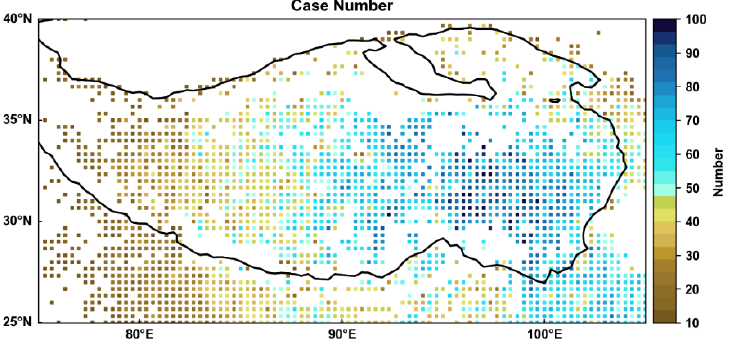
Figure 1. The schematic diagram of the studied region and the case numbers of the convective cloud product grids in the boreal summer from 2013 to 2017; the black lines are the contour of 3 km terrain height.